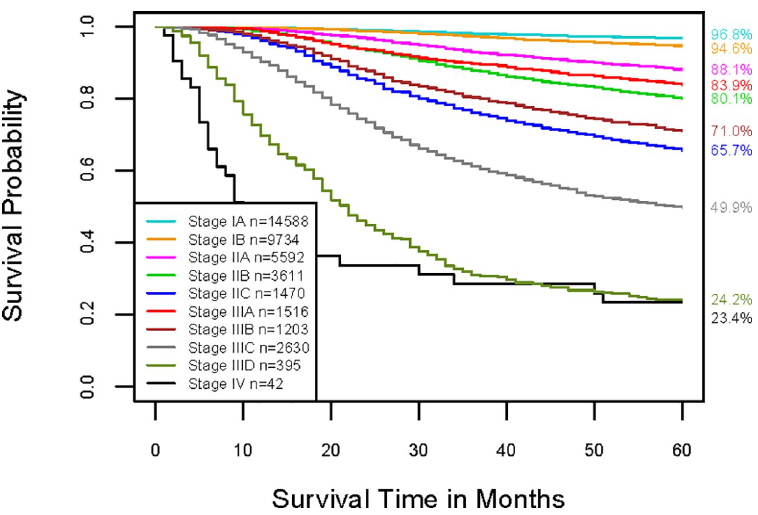
Fig 3. Melanoma-specific survival of AJCC stages of the training data. Stages are defined in the 5th column in S2 Table. The 5-year melanoma-specific survival rates for 10 stages are listed on the right side of the figure.